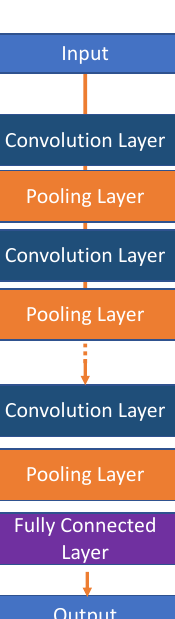
Figure 1. CNN conceptual model (Retrieved from